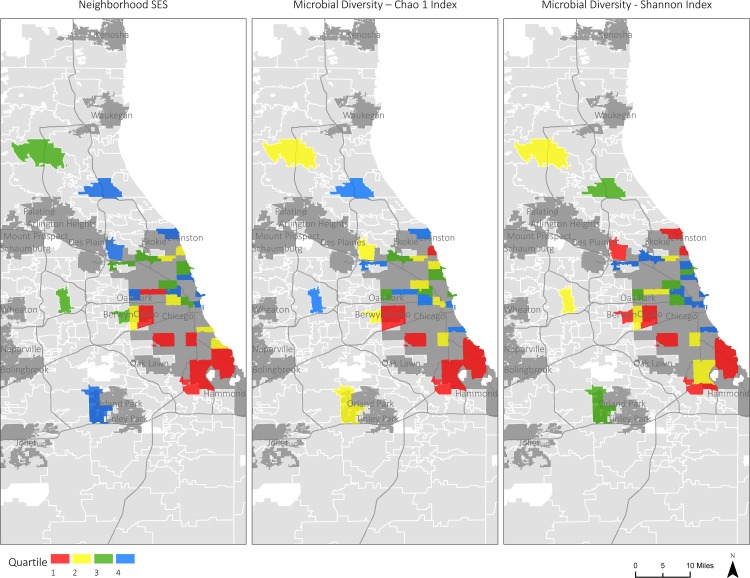
Map depicting the neighborhood SES and alpha-diversity.Map of greater Chicago region, illustrating associations between neighborhood SES and alpha-diversity in biopsies excised from sigmoid mucosa. Depicted are neighborhood SES (left panel), and two metrics of diversity, the Shannon (middle panel) and Chao1 (right panel) indices. For each variable, the sample was divided into quartiles, and neighborhoods were colored as follows: Red = lower 25% of sample; Yellow = 26–50%; Green = 51–75%; Blue = upper 25%. Geospatial data sources: Urban place area from TIGER/Line US Census 2010; Illinois and Wisconsin zip codes from TIGER/Line US Census 2010; Water area from TIGER/Line US Census 2010; Interstate lines from TIGER/Line US Census 2010.